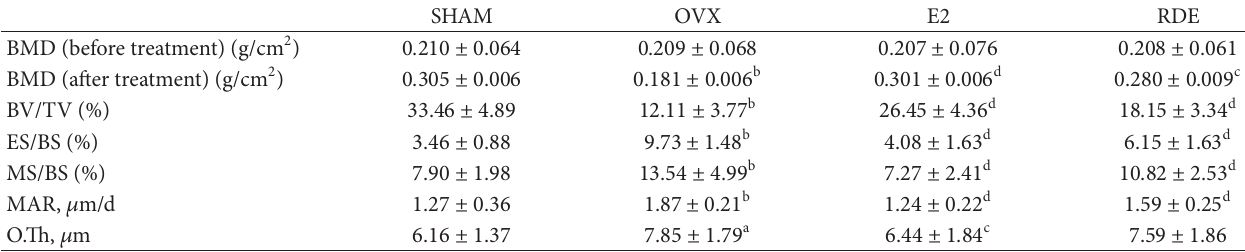
Table 2: Effect of RDE on BMD and trabecular bone histomorphometric indices after 12 weeks of treatment. SHAM BMD (before treatment) (g/cm 2